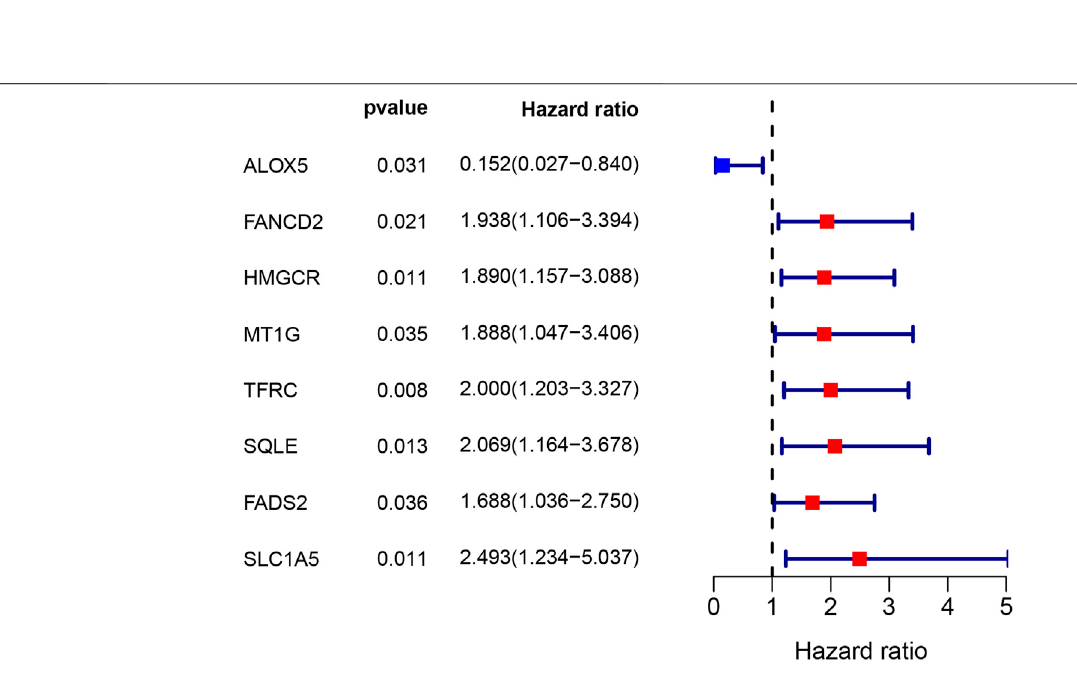
FIGURE 2 | Eight ferroptosis-related genes of predictive value for overall